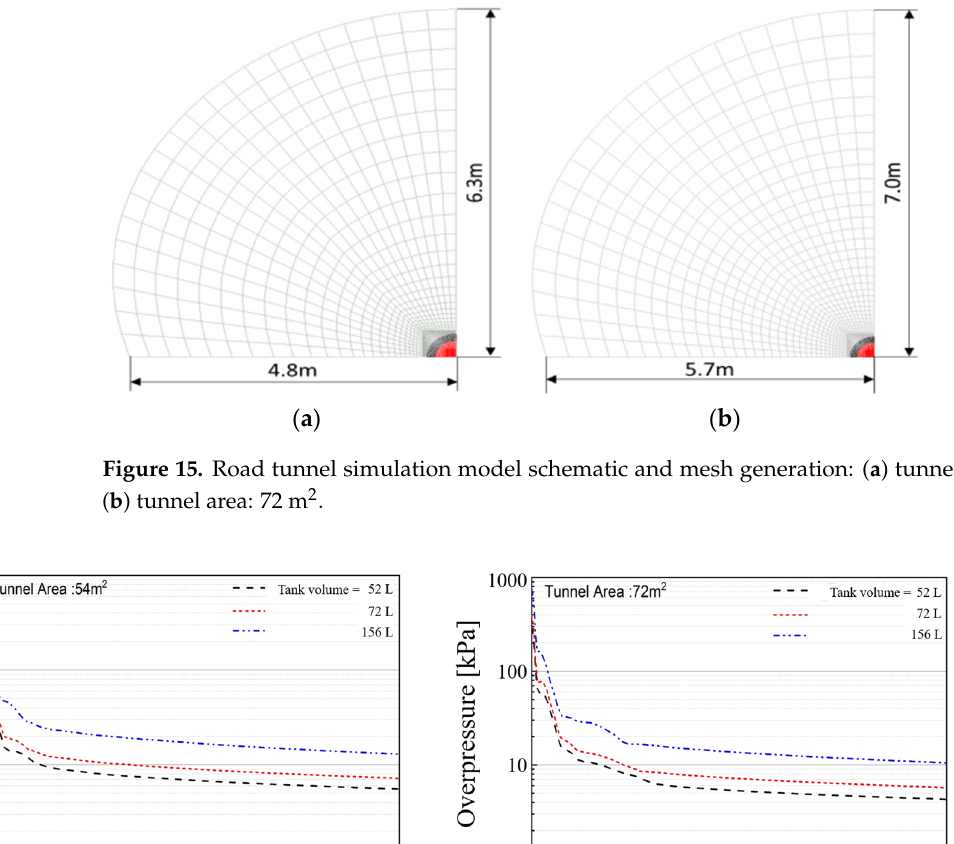
Figure 15. Road tunnel simulation model schematic and mesh generation: ( a ) tunnel area: 54 m 2 ; ( b ) tunnel area: 72 m 2 .